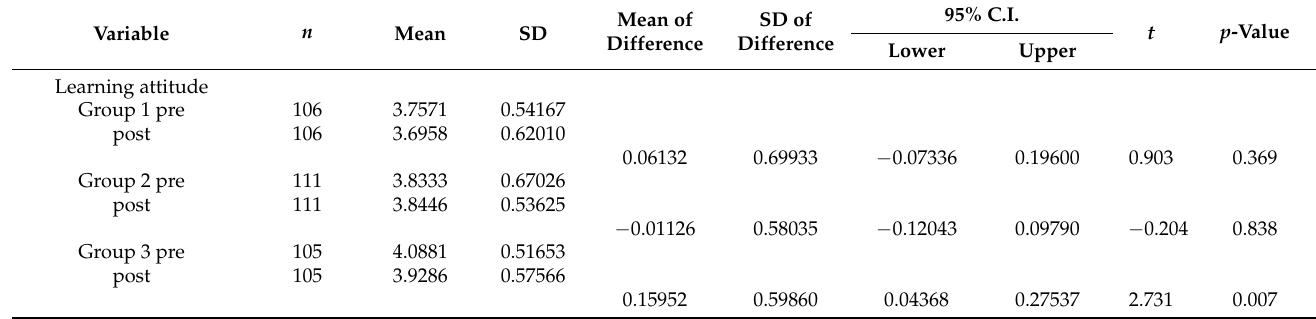
Table 3. Comparison of the differences in students’ self-evaluations of core competencies between groups. (Paired-samples t